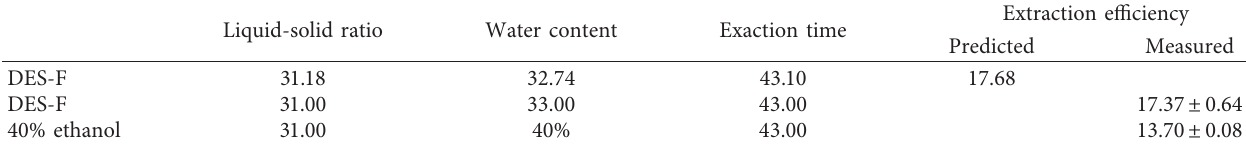
Table 5: Comparison of the EEs obtained using 40% ethanol and DES-F under the optimized conditions. Liquid-solid ratio